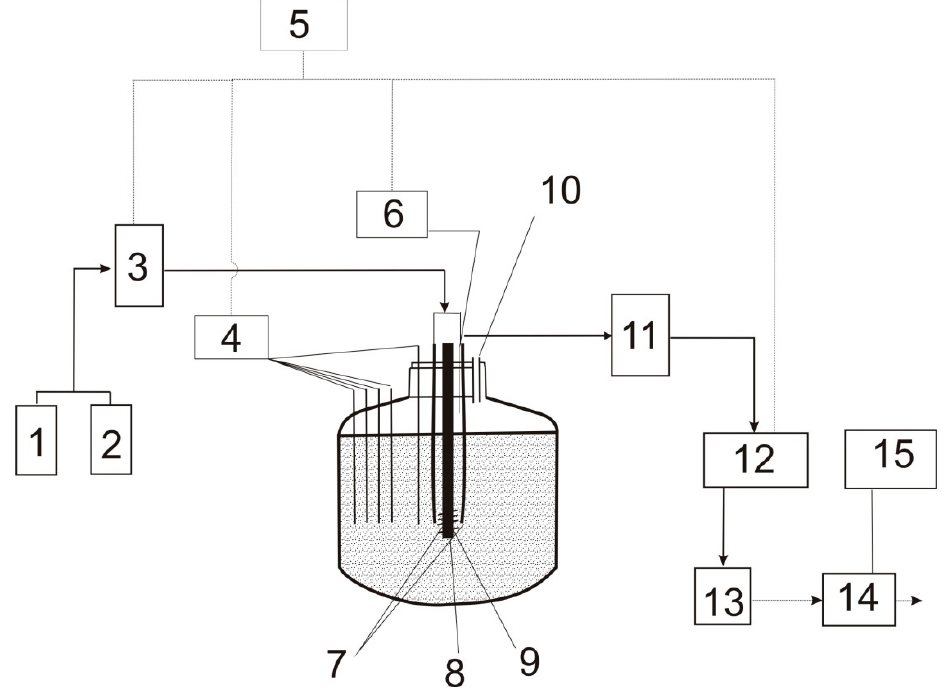
Figure 2. Diagram of a test stand for testing the process of coal heating: 1—synthetic air, 2—nitrogen,